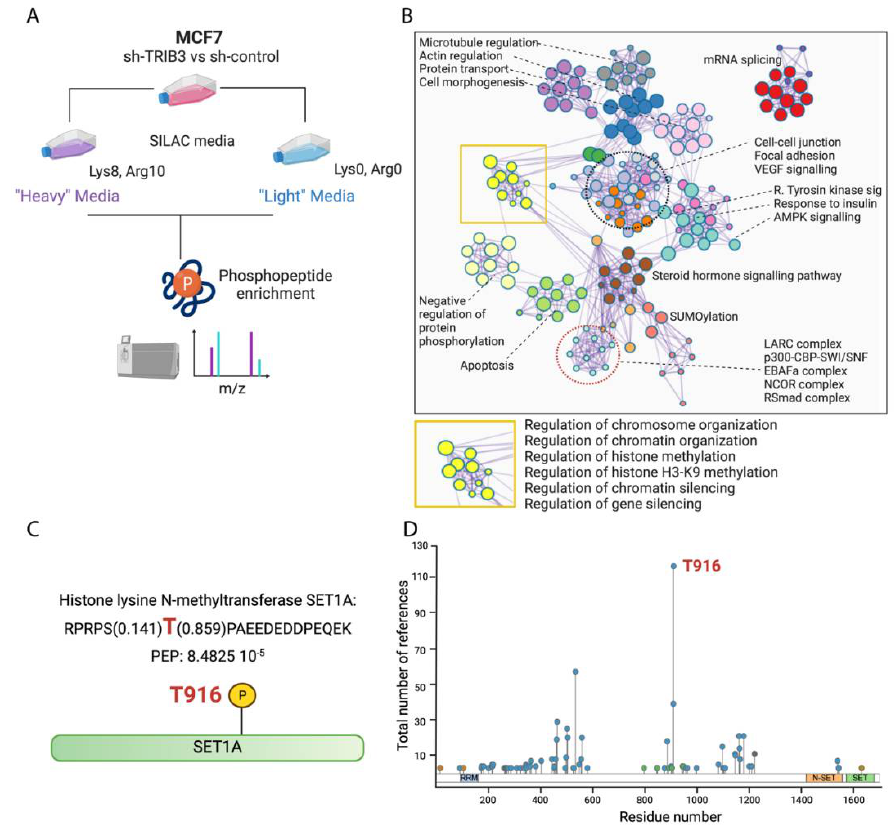
Figure 2. The phosphoproteome of TRIB3 knock-down cells reveals downstream targets of TRIB3. ( A ) Schematic representation of phosphoproteomics experiment using SILAC. ( B ) Pathway analysis using Metascape [41] of phospho-peptides found differentially phosphorylated in Sh-TRIB3 compared to Sh-control in MCF7 cells. ( C ) Schematic representation of phosphorylation of T916 in SET1A. ( D ) Post-translational modifications in SET1A according to Phosphositeplus ® [42]. 2.3. TRIB3 Interacts with WDR5 and ASHL2 Subunits of the WRAD Complex and with the